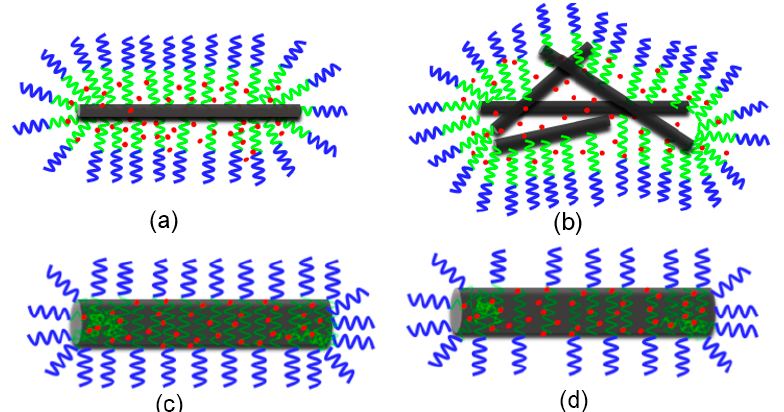
Figure 9. Schematic representation of the possible formation structures of drug-loaded MPEG- Figure